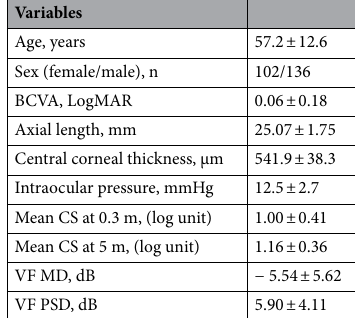
Table 1. Clinical characteristics of participants. BCVA = best corrected visual acuity; LogMAR = Logarithm of the Minimum Angle of Resolution; CS = contrast sensitivity; VF = visual field; MD = mean deviation; PSD = pattern standard deviation.